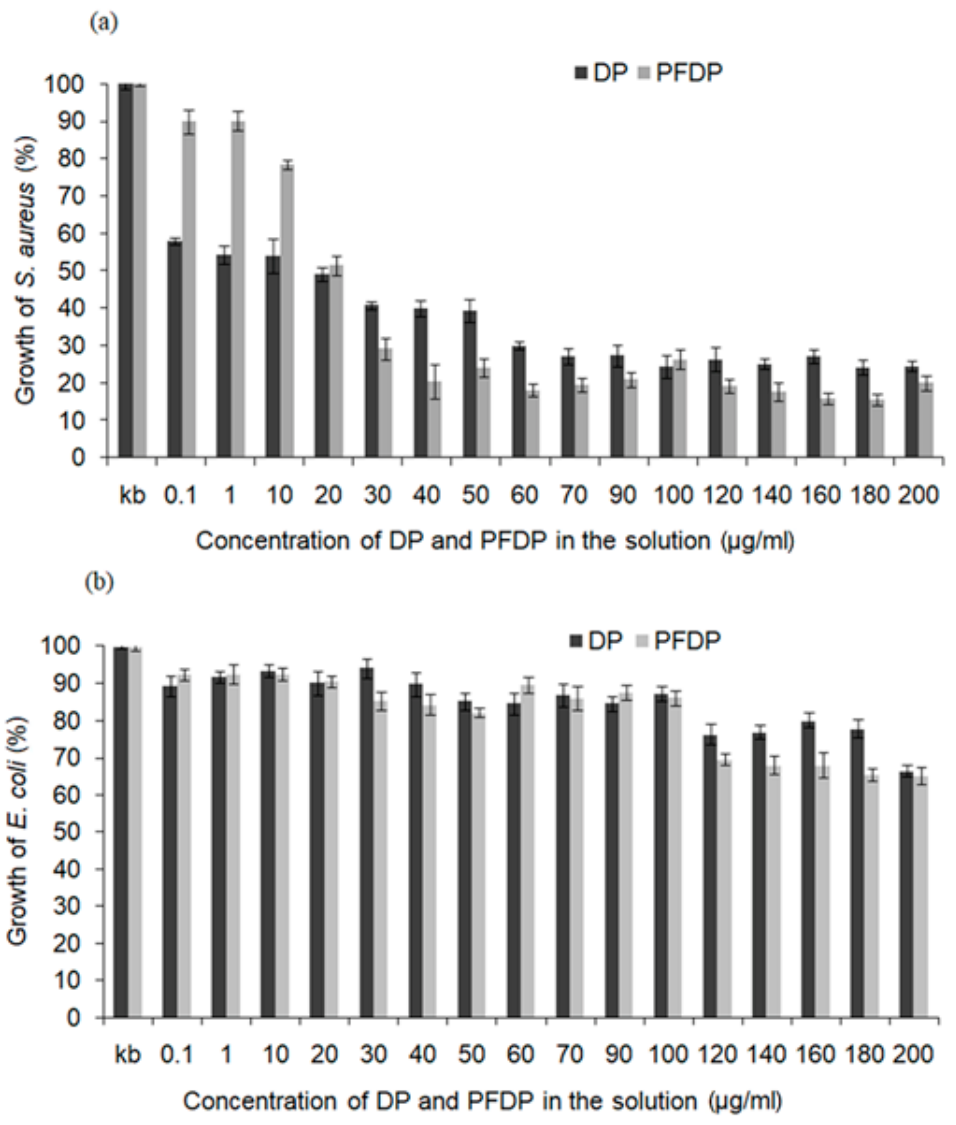
Figure 5. The growth of ( a ) Staphylococcus aureus and ( b ) Escherichia coli after 24 h of incubation with perfluoro and alkylphosphonic acids (DP, PFDP). Each bar represents the average and SD taken from n ≥ 3 wells from three independent experiments. The comparison was made using one-way analysis of the Student t -test. * p < 0.05 vs. control group.